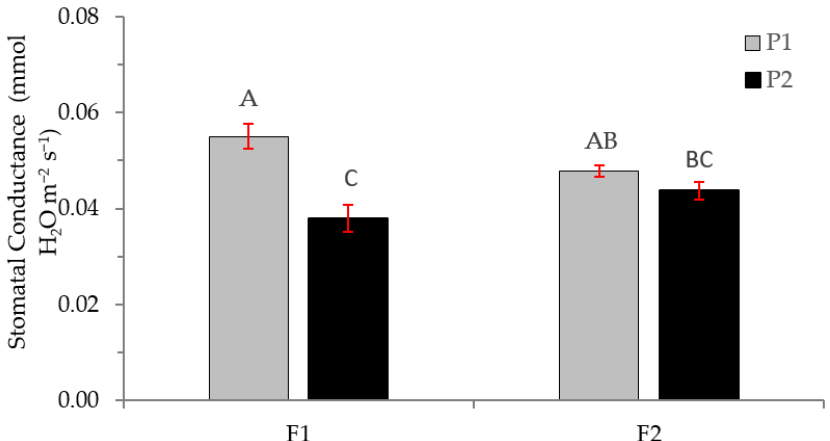
Figure 8. Stomatal conductance in Nothofagus alessandrii plants as a function of MFI treatment (M0, M1, and M2). Different letters represent significant differences at p < 0.05.